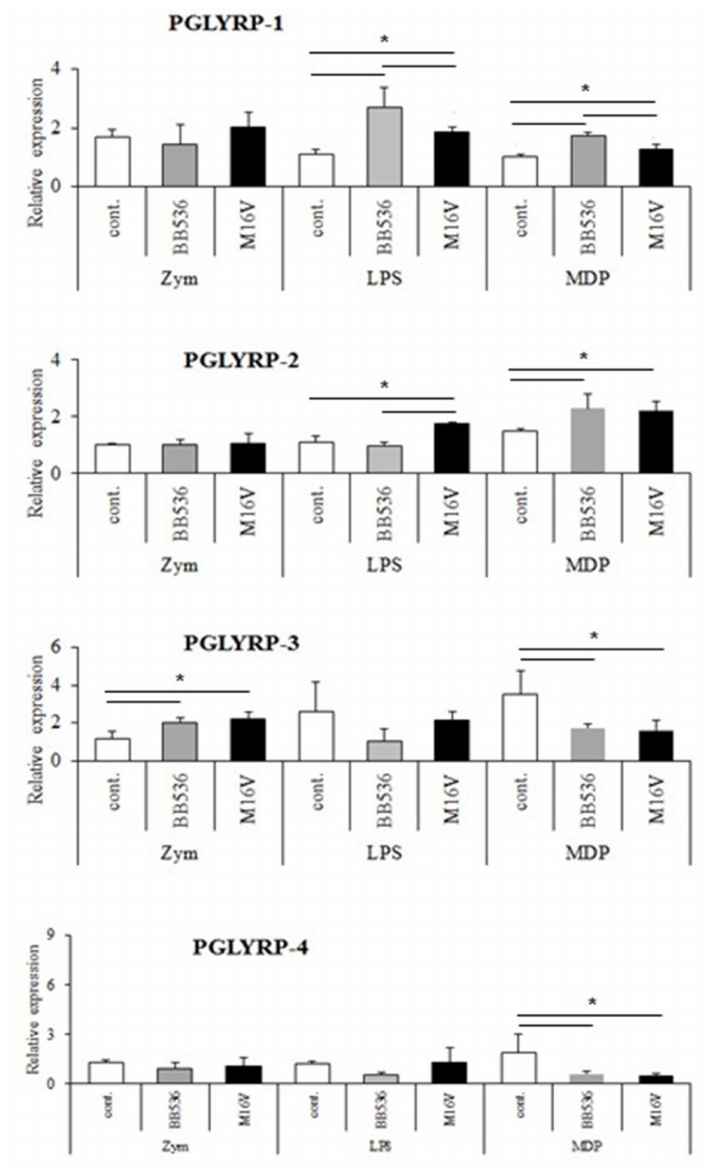
Figure 6. Modulation of peptidoglycan recognition proteins (PGLYRP) expressions by the interactions of pattern recognition receptor (PRR)-ligands and immunobiotics in porcine intestinal epithelial (PIE) cells. The PIE cells were pre-stimulated with Bifidobacterium longum subsp. longum BB536 or B. breve M-16V followed by the stimulation with zymosan (ZYM), lipopolysaccharide (LPS) or Muramyl dipeptide (MDP). PGLYRP mRNA expression level was normalized with the porcine β -actin mRNA, and the normalized fold expression was determined in comparison to the PGLYRP mRNA level of non-stimulated PIE cells. The results are shown as means ± standard deviation obtained from three independent experiments ( n = 6). * p < 0.05 against control or against the indicated experimental